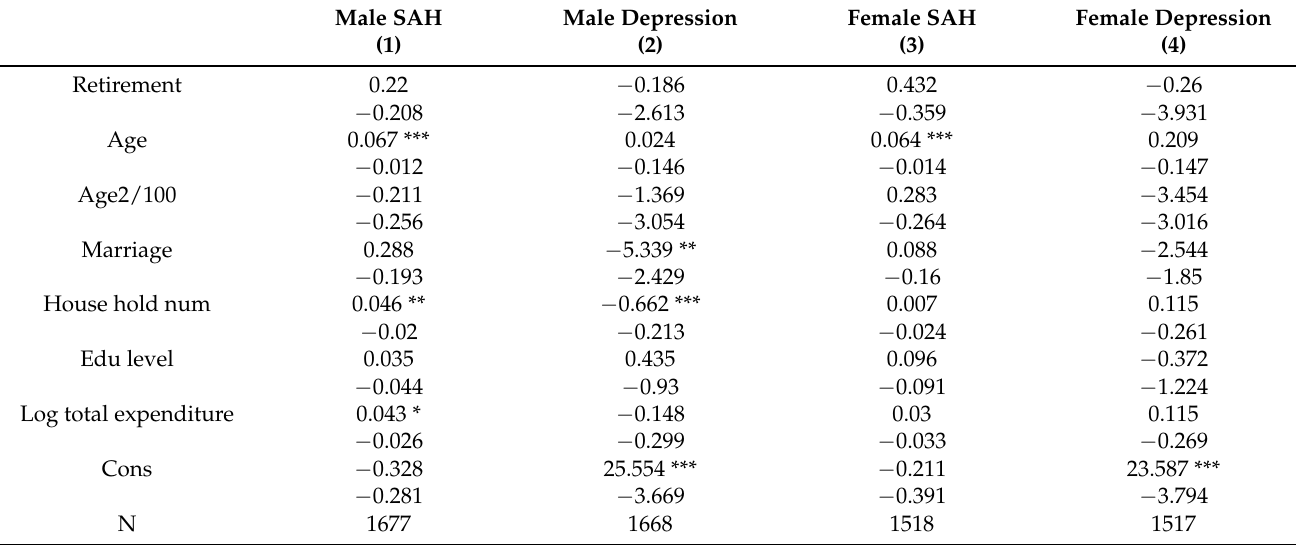
Table A4. Effect of retirement on SAH and depression by